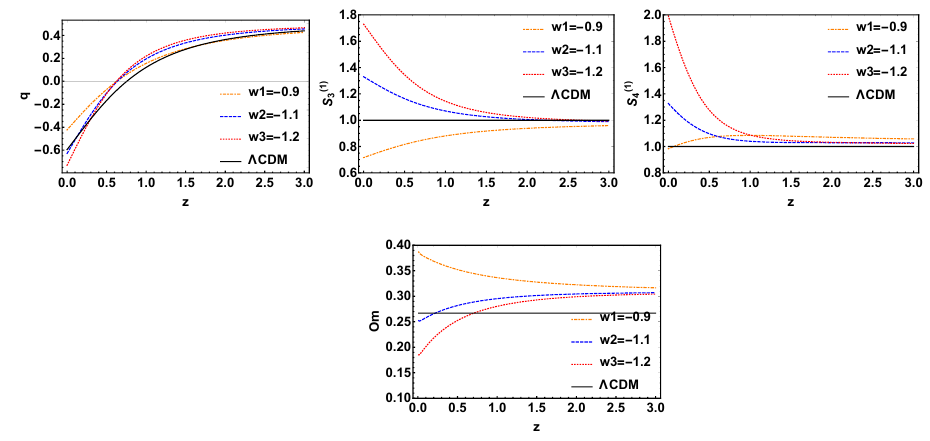
( 1 ) ( 1 ) , S and Om , respectively, versus red shift z for the 3 4